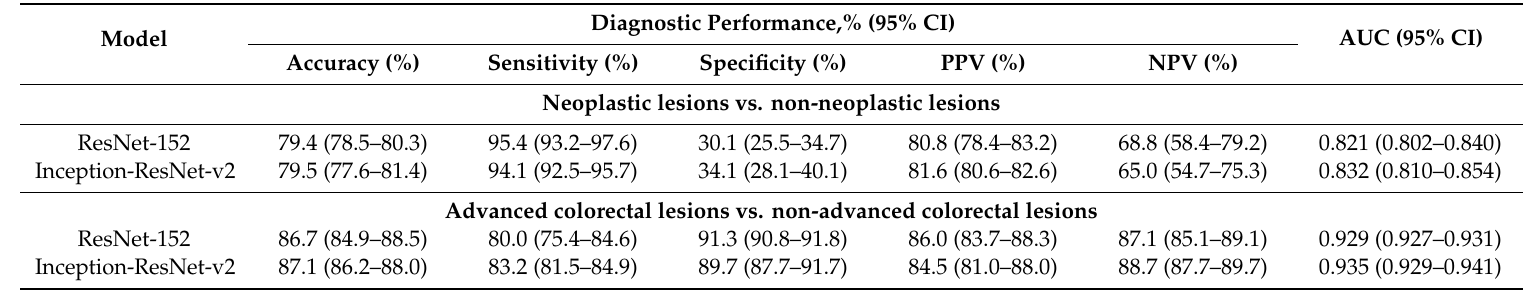
Table 1. Diagnostic performance of deep-learning models for binary classification of colorectal lesions on colonoscopic photographs in the test dataset.